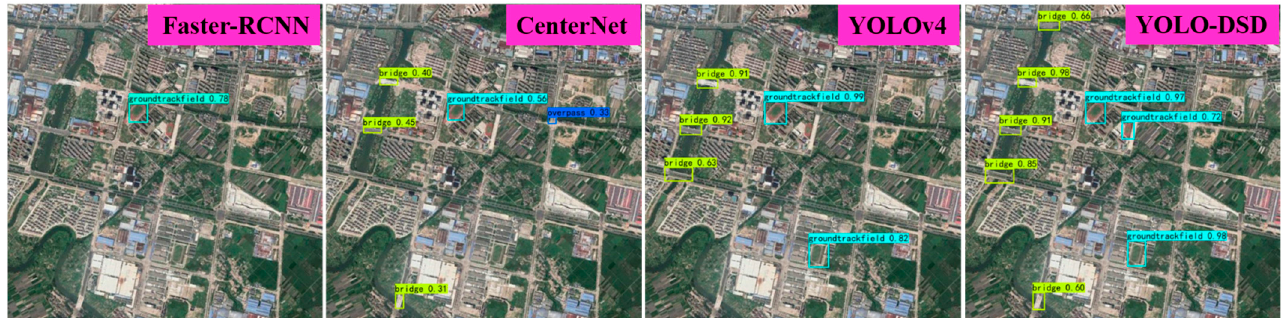
Figure 16. The detection result of instance in complex suburban background.